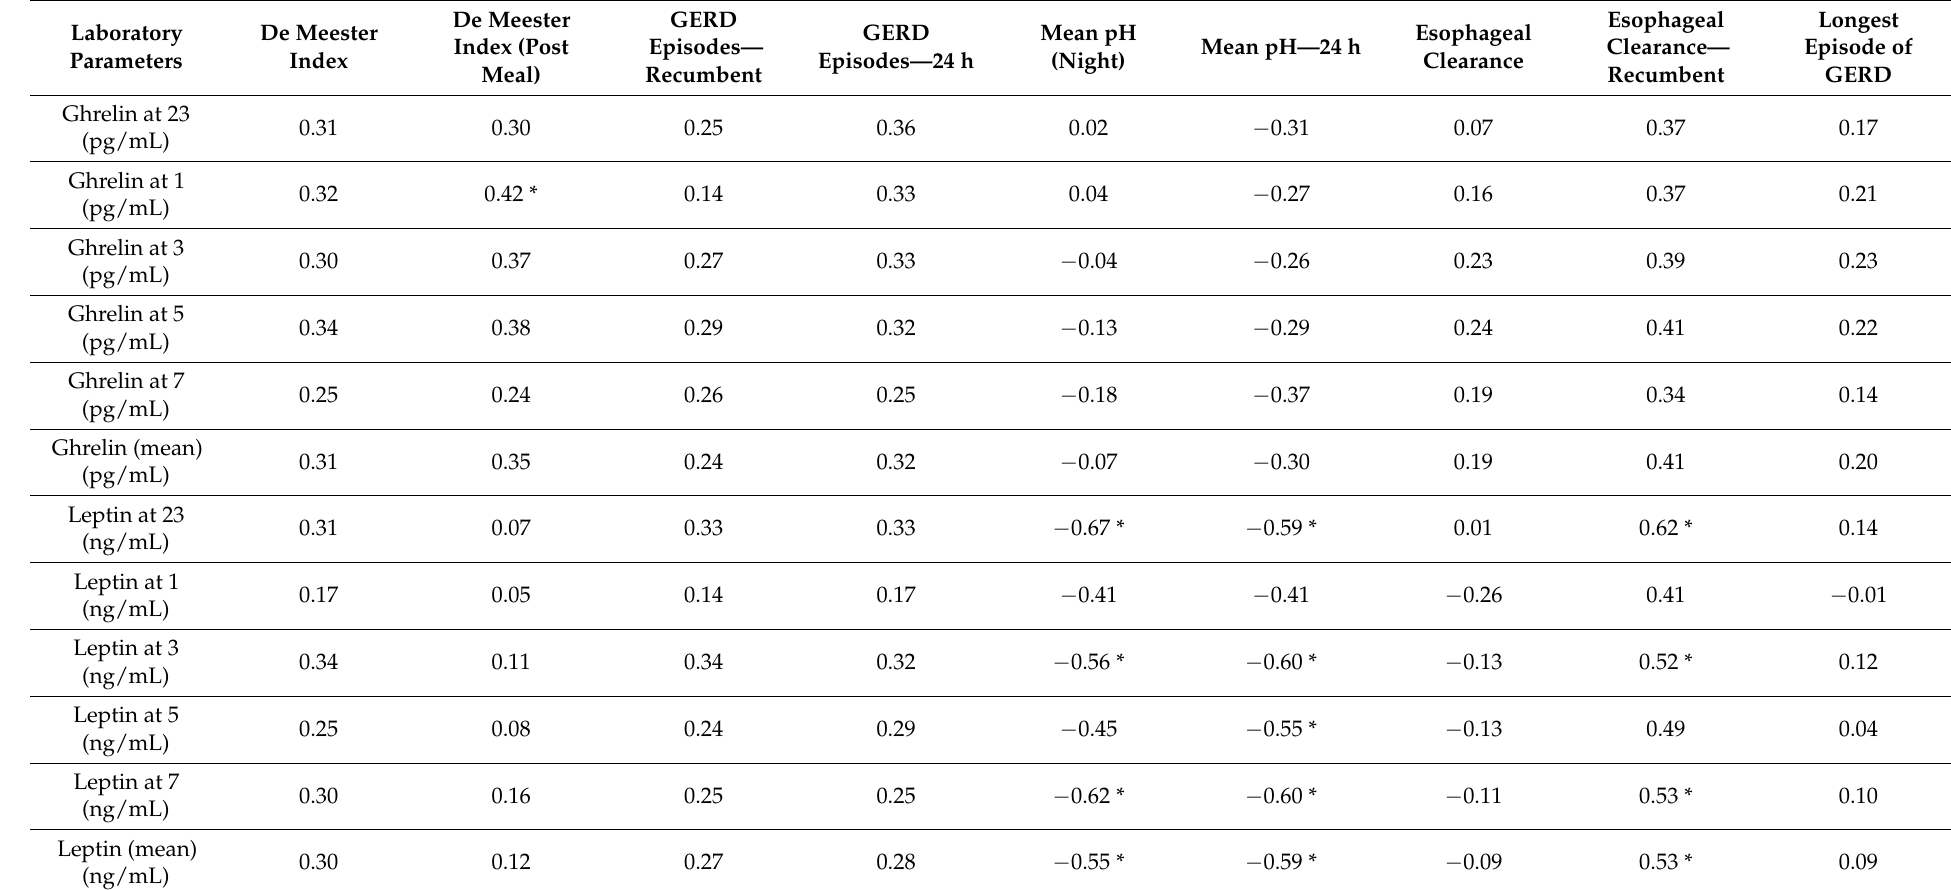
Table 8. Correlations between ghrelin, leptin, and obestatin concentrations and selected parameters of esophageal pH monitoring (statistically significant correlations, where p < 0.05, are marked using